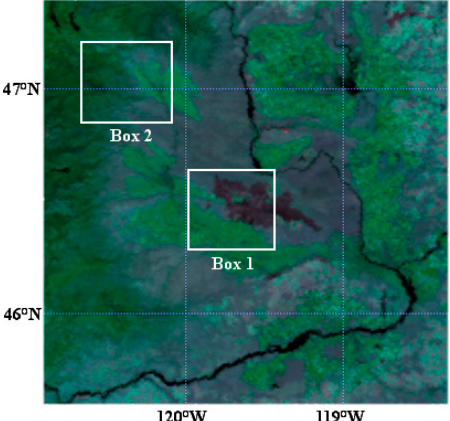
Figure 3. False-color composition MODIS RGB image (red: 2.13 µ m; green: 1.24 µ m; blue: 1.64 µ m) acquired from Range 12 Fire on 6 August 2016. Box 1 contains samples of burned area and unburned types while Box 2 contains only unburned samples.